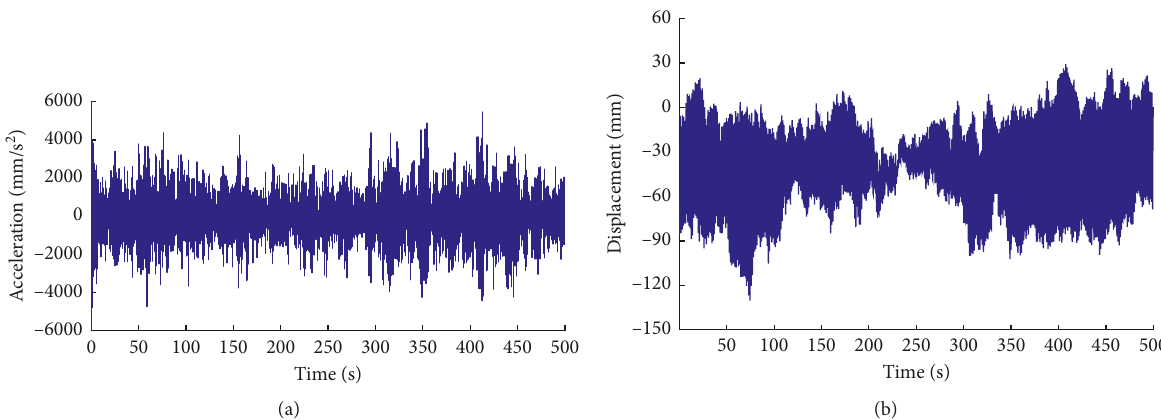
Figure 4: Time-history curves of acceleration and displacement at 75m: (a) acceleration at 75m; (b) displacement at 75